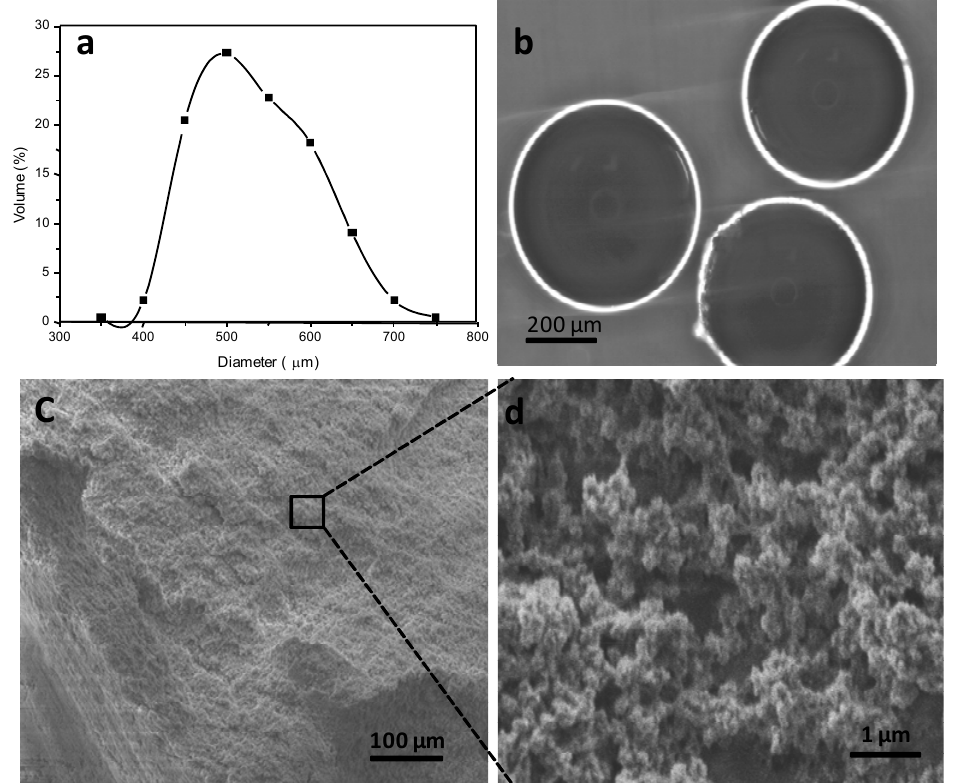
Figure 3. Characterization of MBAX microspheres. ( a ) Diameter distribution; ( b ) Optical microscope observation; ( c and d ) SEM